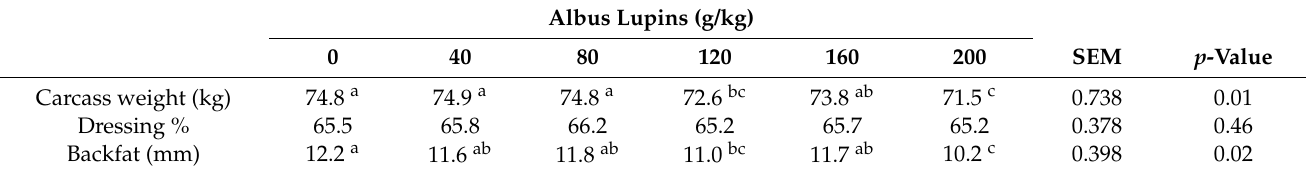
Table 4. Carcass data for pigs fed increasing concentrations of albus lupins from 78.9 to 112.4 kg liveweight ( n = 6/treatment). Albus Lupins